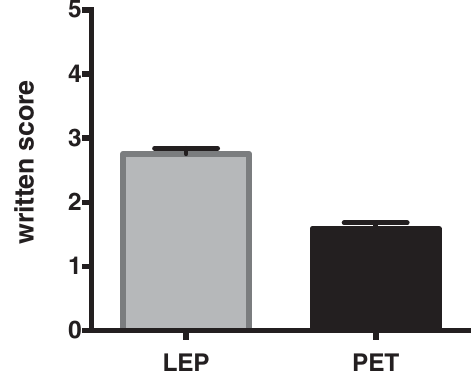
FIG. 5. Average score on the final exam explanation item for LEP ( N ¼ 334 ) and PET ( N ¼ 324 ) students. Error bars are